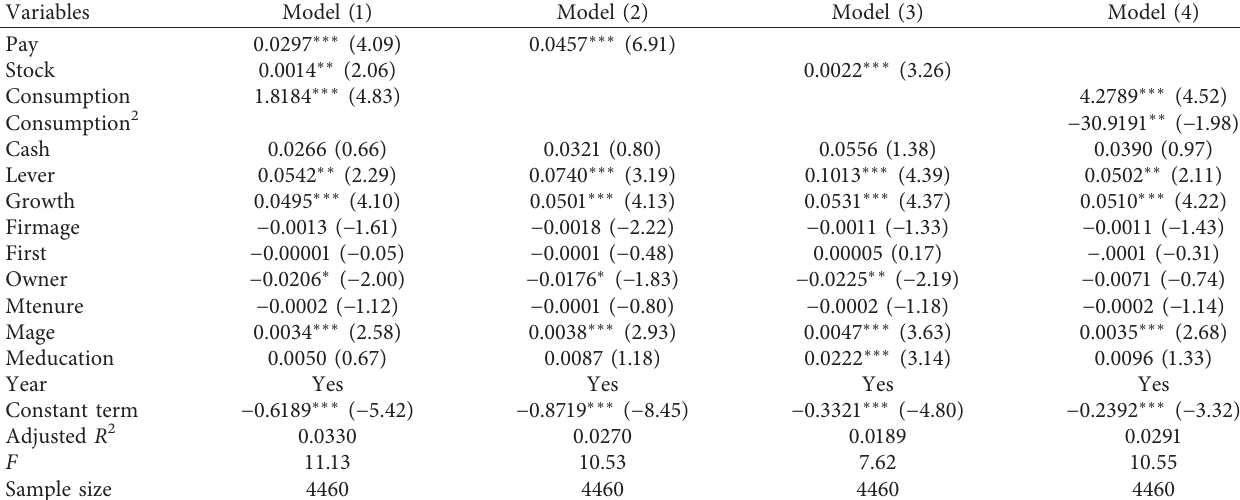
Table 5: Full sample regression analysis results of executive incentive compensation and resource allocation efficiency.